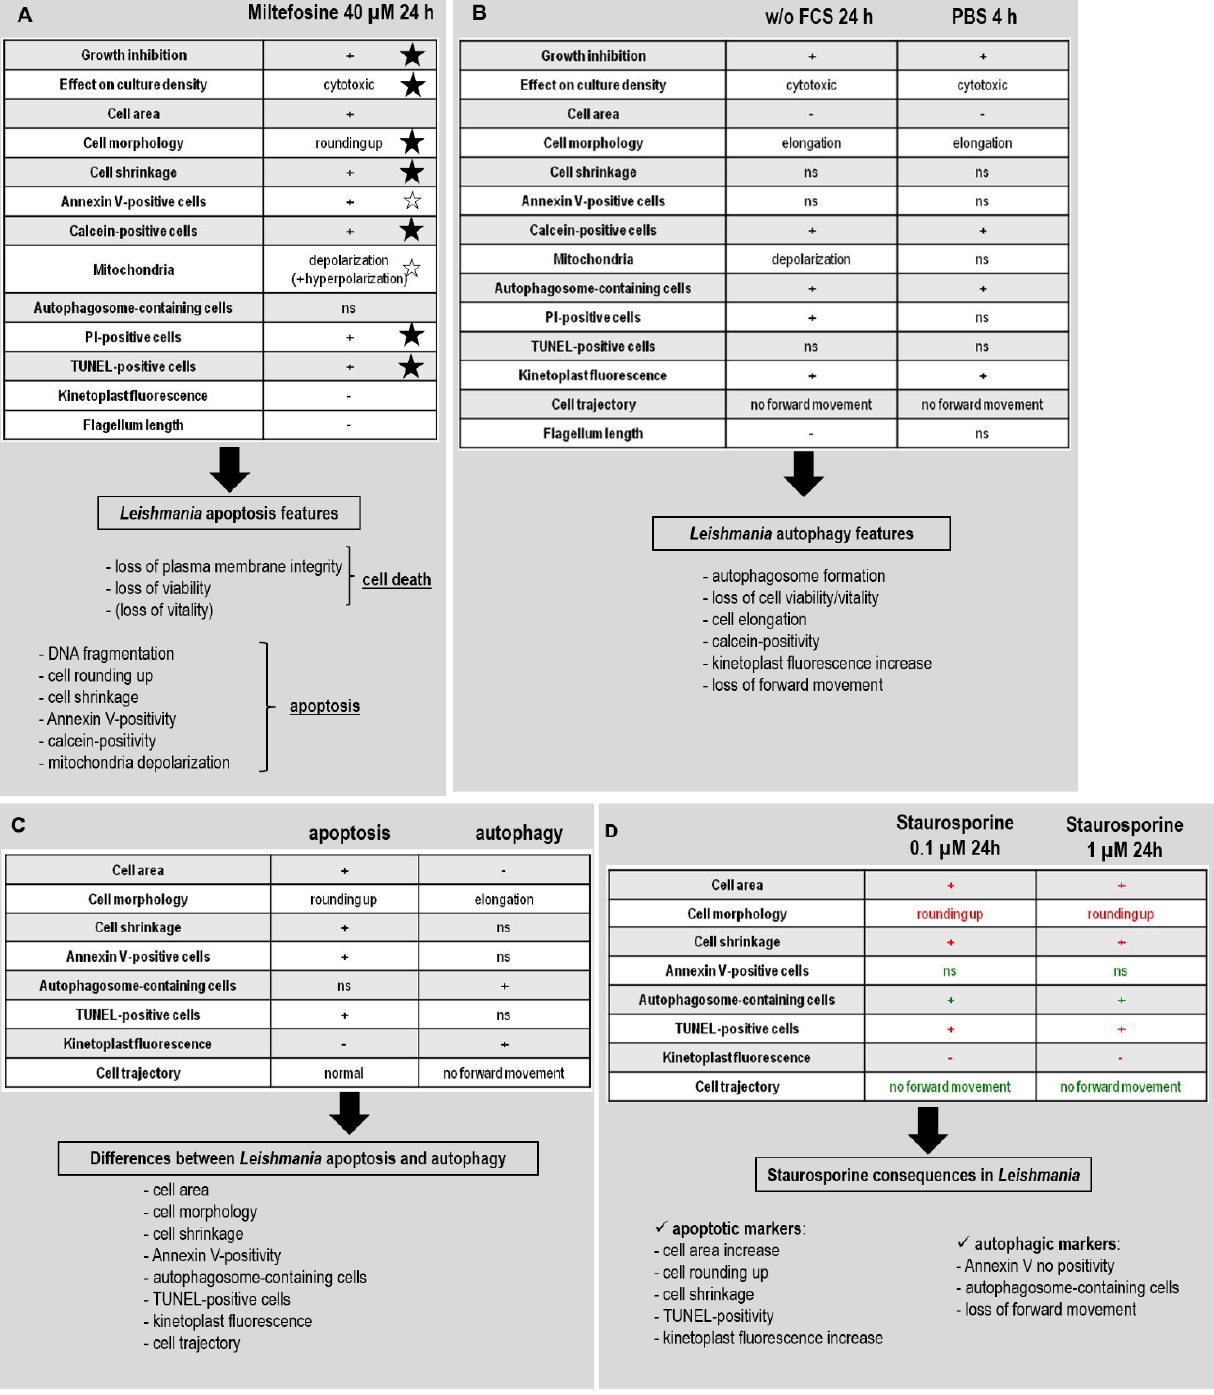
OPEN ACCESS | www.microbialcell.com